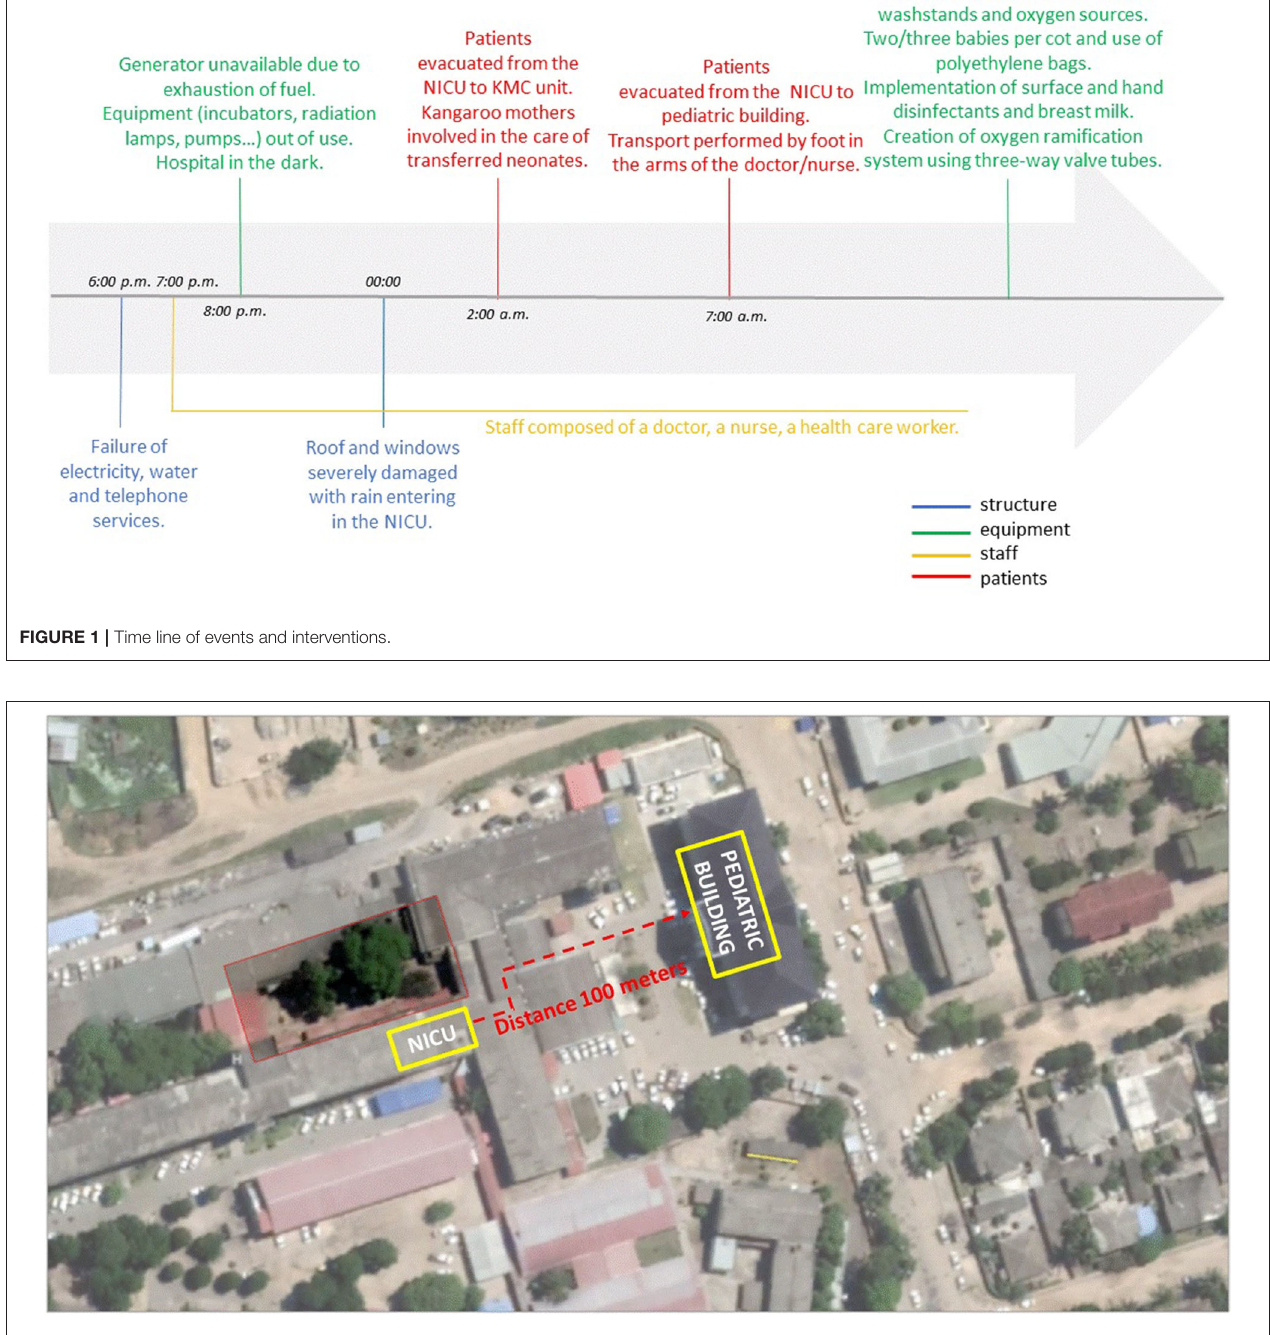
FIGURE 2 | Layout of the original and “new” NICU at the CHB